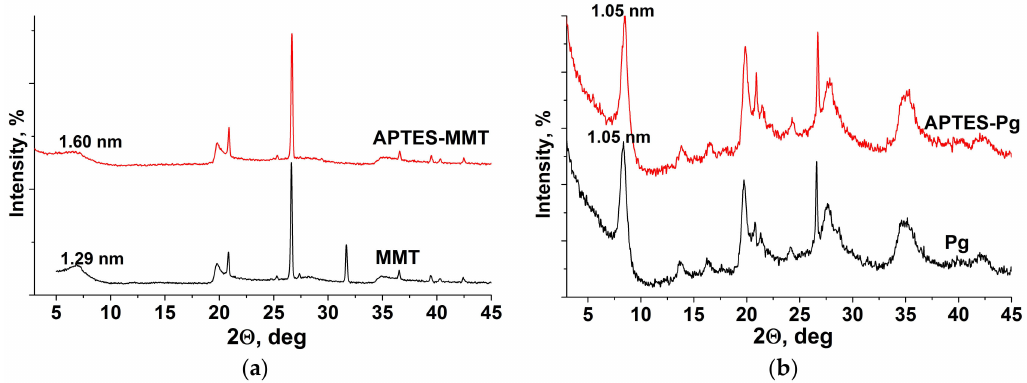
Figure 2. XRD patterns of pristine and APTES-modified clay minerals: ( a ) montmorillonite, ( b ) palygorskite. Findings of the thermal analysis of modified montmorillonite and palygorskite show that unlike nontreated clays, for which thermogravimetry (TG) curves at temperatures up to 800–900 ◦ C reveal only mass loss associated with the removal of different forms of bound water [1], the treated APTES samples reveal mass loss in the temperature interval 300–500 ◦ C that are determined by the thermal decomposition of grafted APTES (Figure 3). The mass loss in this temperature range corresponding to the removal of gaseous products of modifier decomposition amounts up to 10 % for the modified palygorskite and